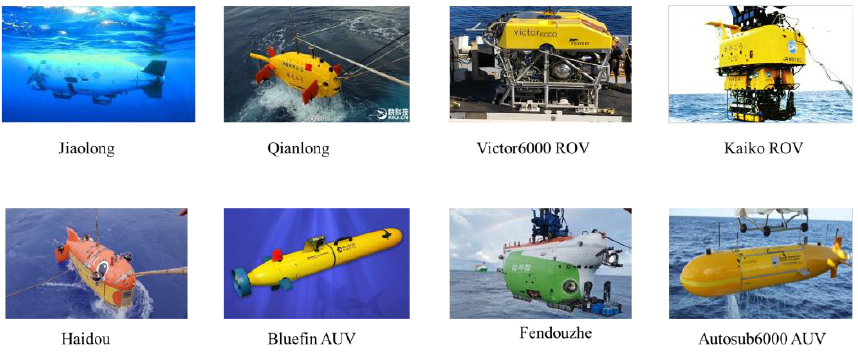
Figure 5. IoUT Robot